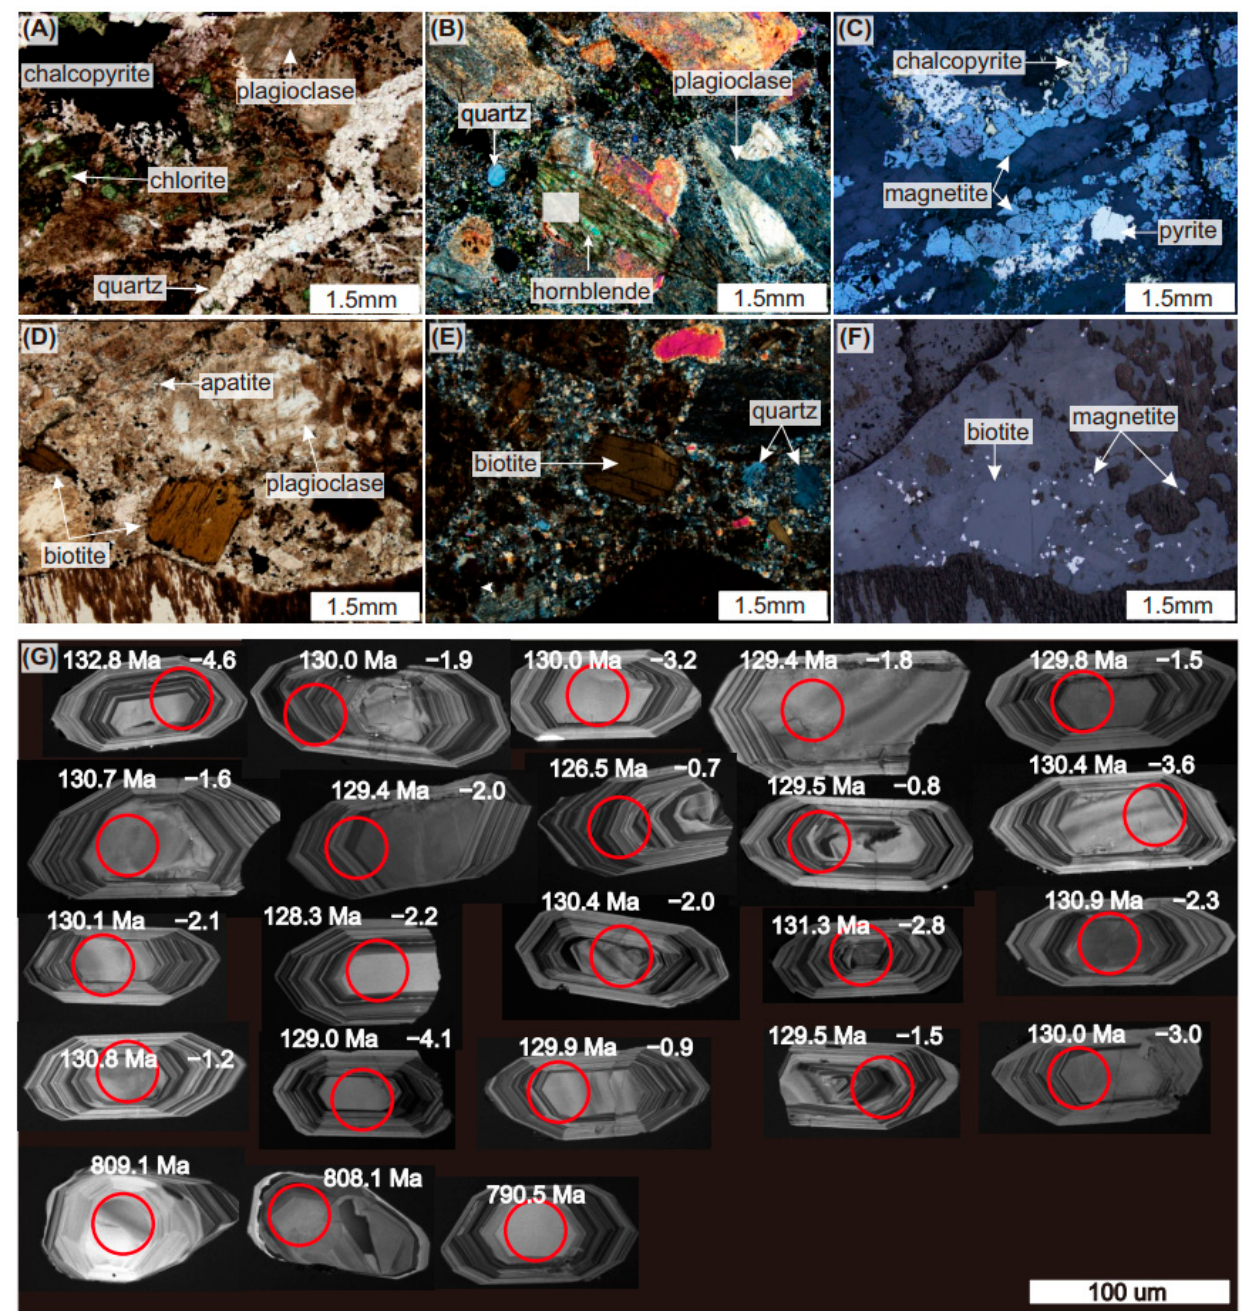
Figure 5. Representative photomicrographs and zircon characteristics of quartz diorite porphyry from Shaxi porphyry Cu–Au deposit. The phenocrysts in the quartz diorite porphyry are mainly plagioclase, hornblende, biotite, and quartz ( A , B , D , E ), and they are closely associated with chalcopyrite and magnetite ( C , F ). Biotites are mostly euhedral crystals and show the characteristic of mag- matic biotite ( D – F ). Zircons from Shaxi have prominent oscillatory zones ( G ), and the U–Pb ages and ε Hf (t) values of these zircons are shown in panel G.